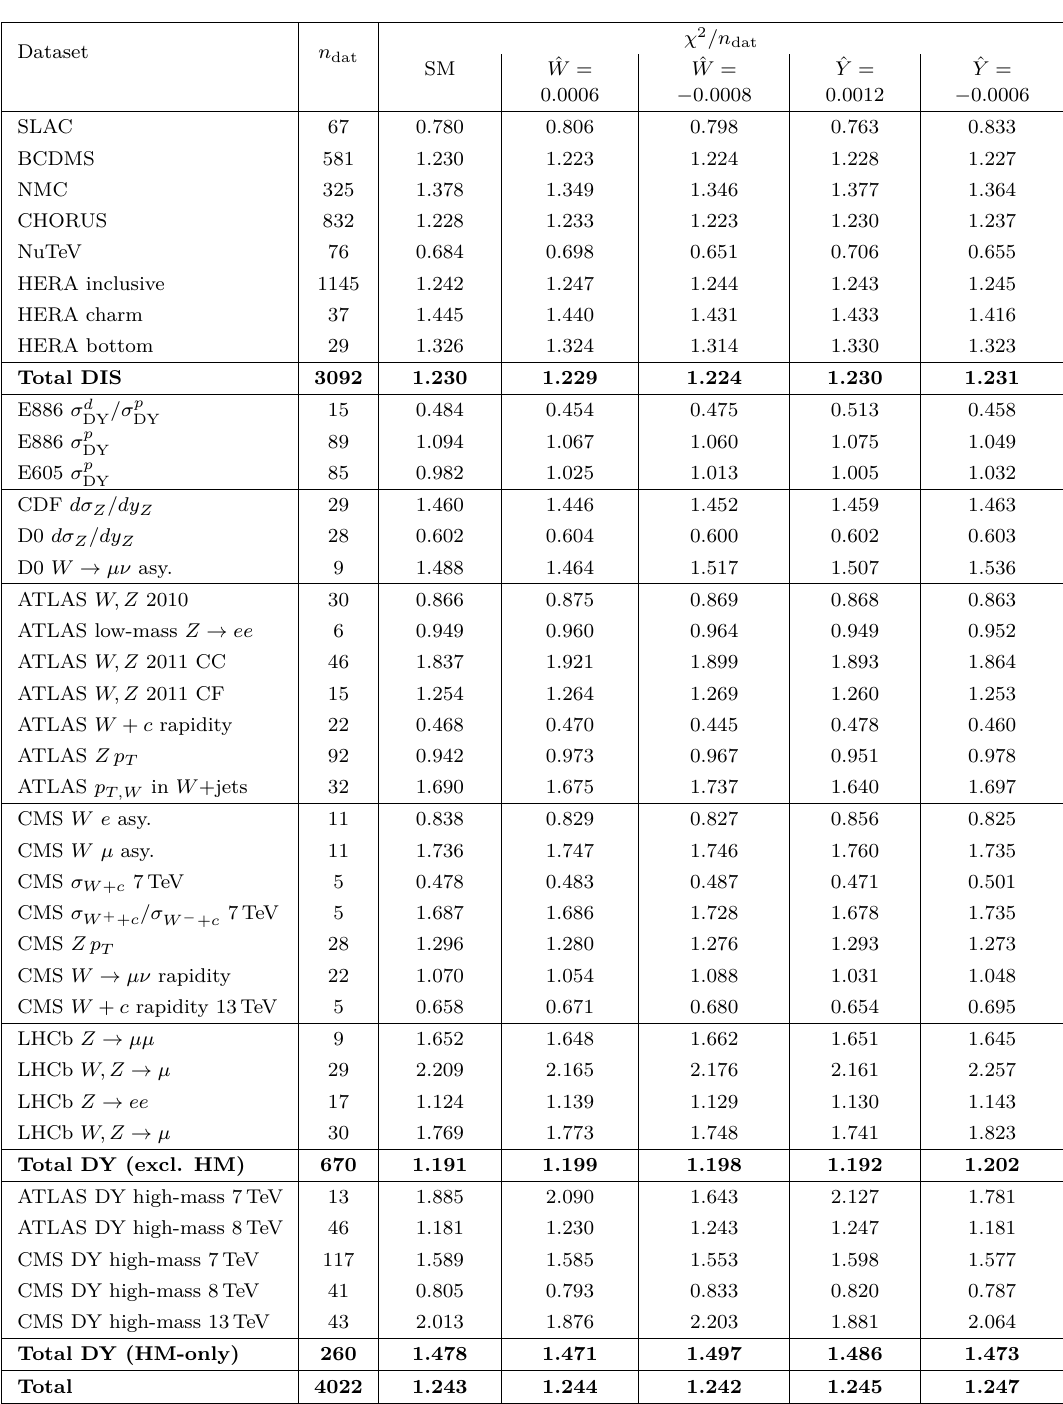
Table 11 . Same as table 10, now comparing the χ 2 values (computed using the t 0 prescription, as above) of the SM PDFs with those of the SMEFT PDFs for different values of the ˆ W and ˆ Y parameters in benchmark scenario I, specifically those displayed in figures 6 and